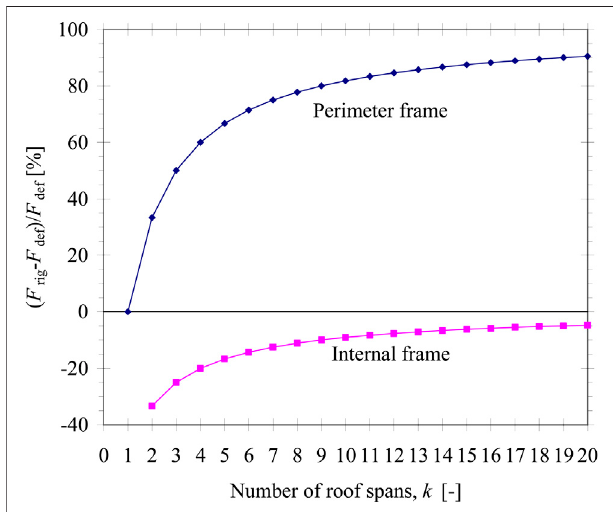
FIGURE 11 | In fl uence of roof stiffening on seismic forces acting on perimeter and internal frames.